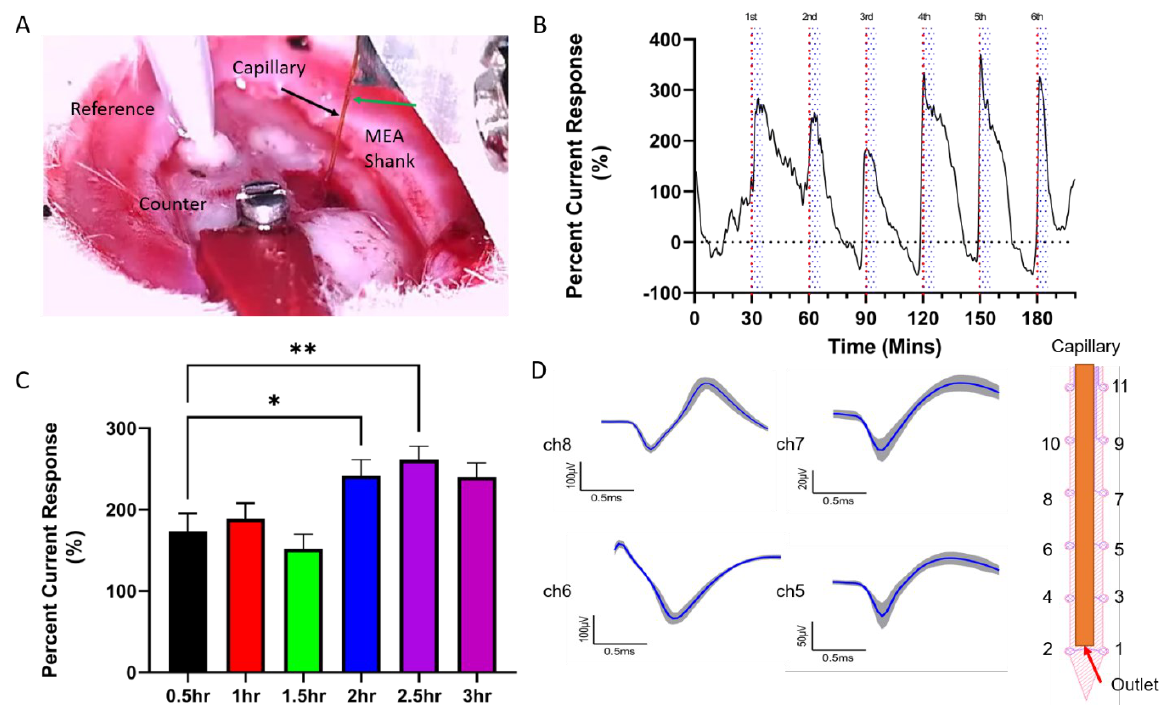
Figure 6. In vivo direct cocaine infusion surgery set-up, data analysis, and representative electrophysiology recordings of single unit waveforms. ( A ) A three-electrode set-up was used for in vivo cocaine sensing. Two holes were drilled on the contralateral side for placement of an Ag/AgCl reference electrode and a stainless-steel screw counter electrode. The flexible MEA shank was implanted 5 mm deep in the striatum using the capillary as shuttle. ( B ) Average percent current response to repeated cocaine injection over 200 min across 3 MEAs implanted in 3 rats. The red dashed line indicates the timing of repeated cocaine infusion every 30 min. The blue shaded regions indicate the 5 min time bins used to average the current response at different time points. Total number of electrode sites n = 9. ( C ) Average percent current response every 0.5 h from 3 implanted MEAs in 3 rats. At the 2 h and the 2.5 h time point, a significant increase in response was observed. Total number of electrode sites n = 9, * p < 0.05, ** p < 0.01. mean + SEM. One-way ANOVA, Dunnett’s test, 0.5 h response set as control. ( D ) Scheme of electrode site mapping, location of the capillary outlet, and representative single unit waveforms from electrophysiology recordings. The probe shank is 150 µm wide and vertical spacing of electrode sites is 300 µm. Capillary outlet is aligned with channel 1 and channel 2. channel 5 and 6 and | channel 7 and 8 are groups of electrodes at the same depth but recorded different units that have distinct waveforms.